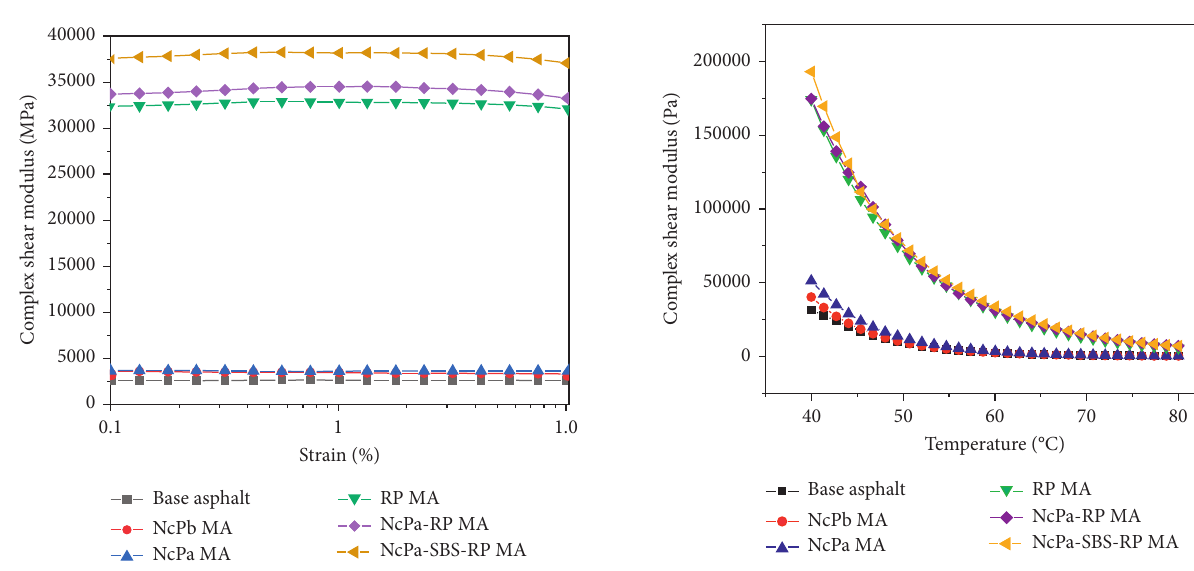
Figure 4: Complex shear modulus versus strain.